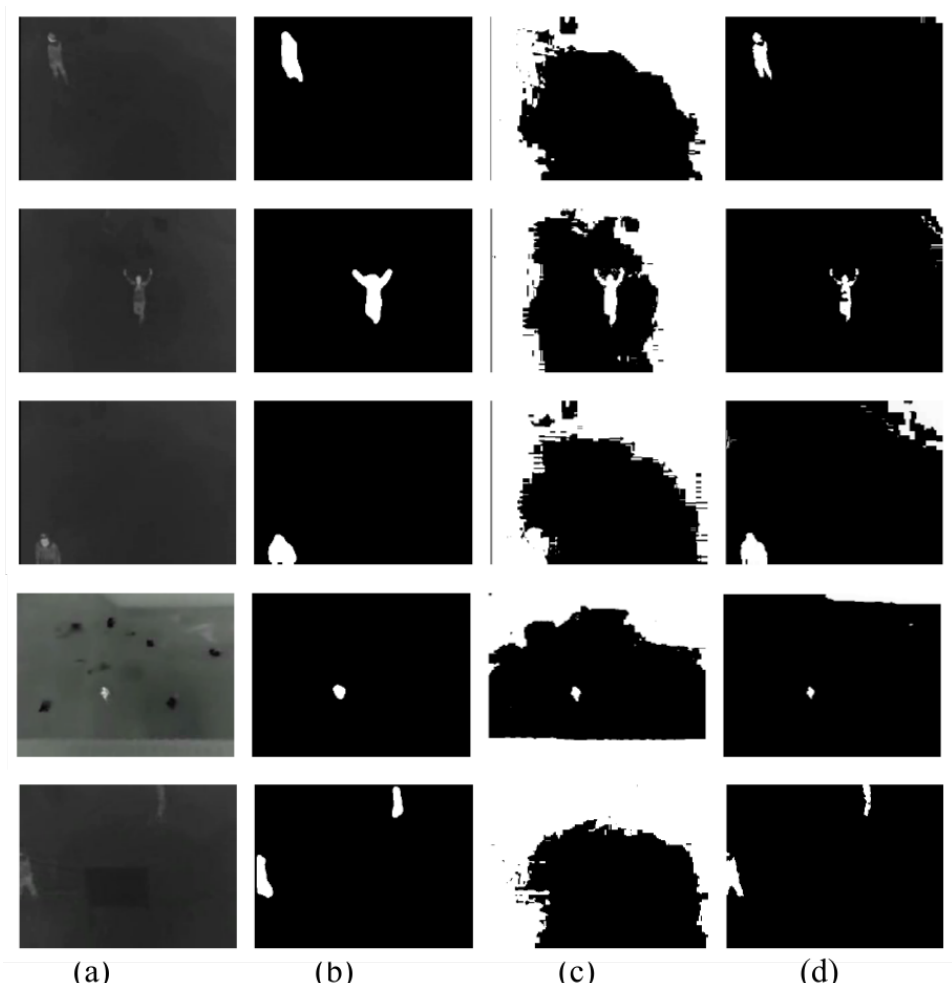
Figure 4. Comparison of outputs using MCET and the proposed method on images from the LITIV database. ( a ) Original image; ( b ) ground truth; ( c ) minimum cross entropy; ( d ) proposed